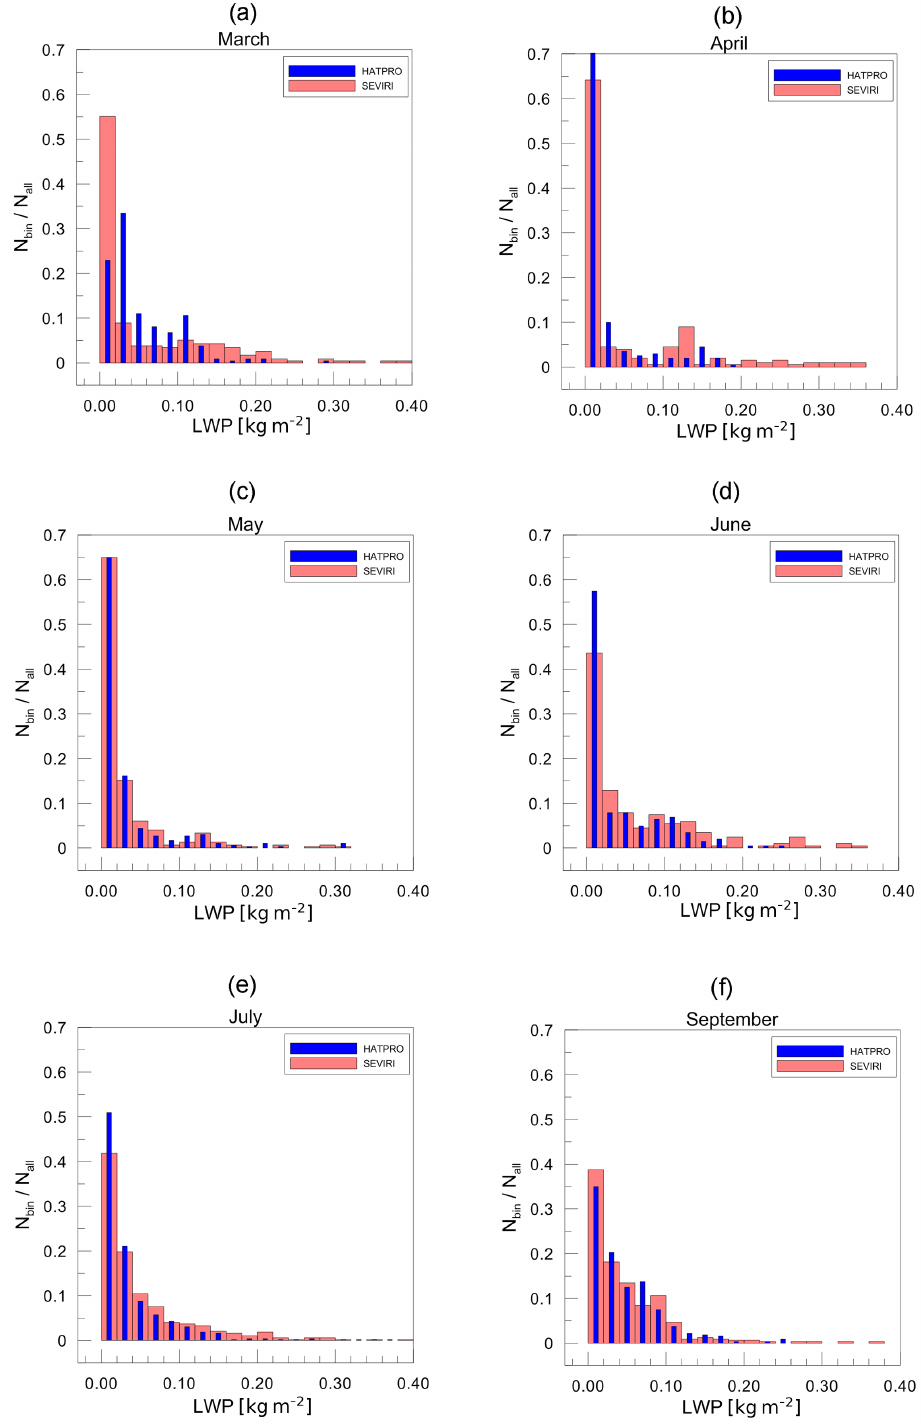
Figure 11. Monthly frequency distribution of LWP for HATPRO and SEVIRI normalised with the total number of occurrence. Six months with the largest number of instantaneous measurements are